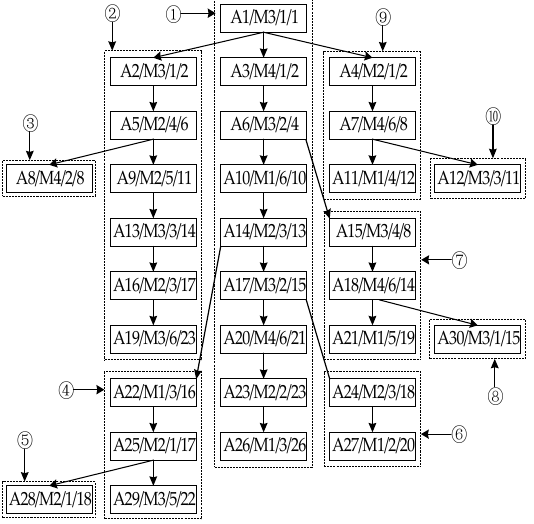
Figure 2. Division diagram of PS when establishing the 1st LA.